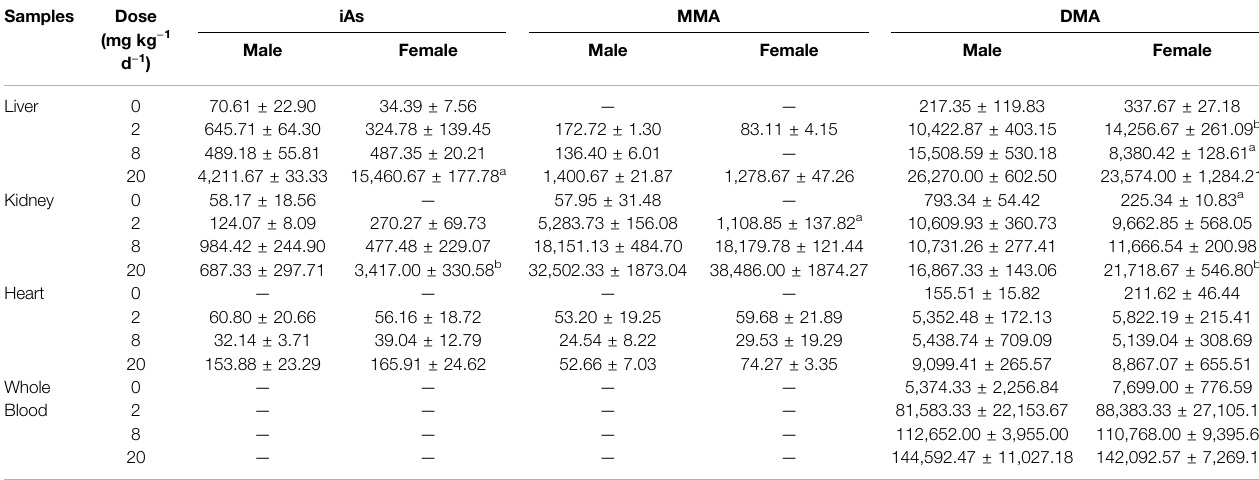
TABLE 4 | Tissue and blood arsenic metabolites concentration following oral administration of ATO for 28 days. Samples Dose (mg kg −